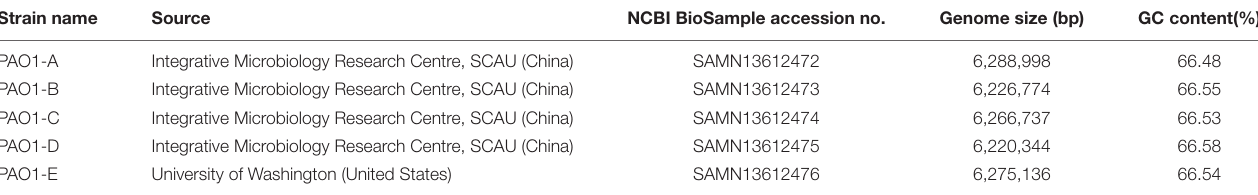
TABLE 1 | Strain selection and genome